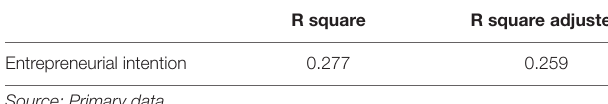
TABLE 6 | Coefficient of determination (R 2 ).